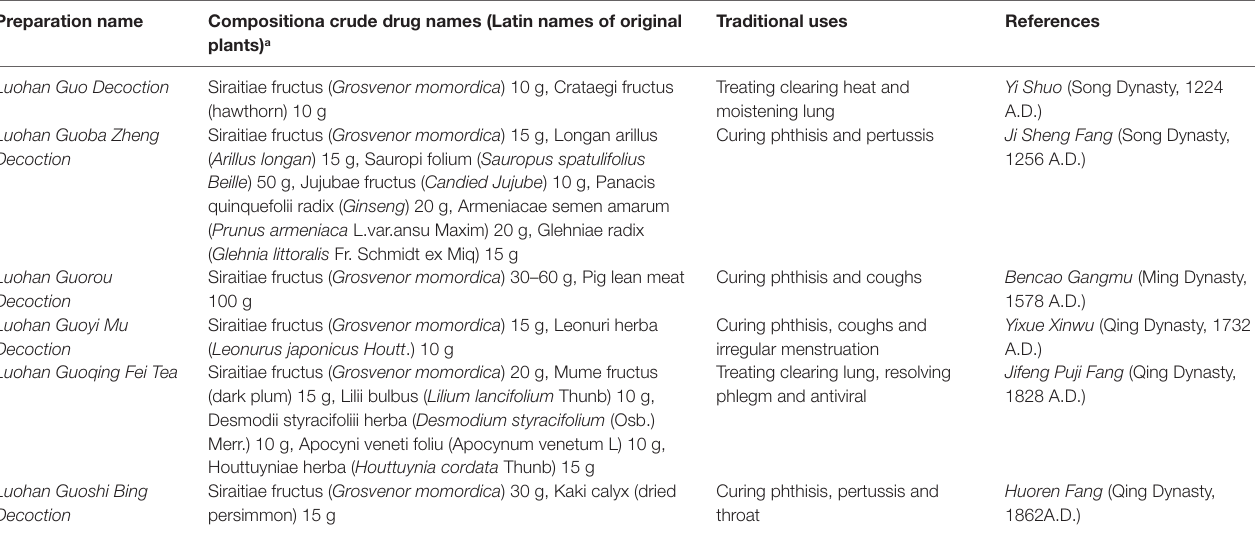
TABLe 2 | Traditional uses of S. grosvenorii in